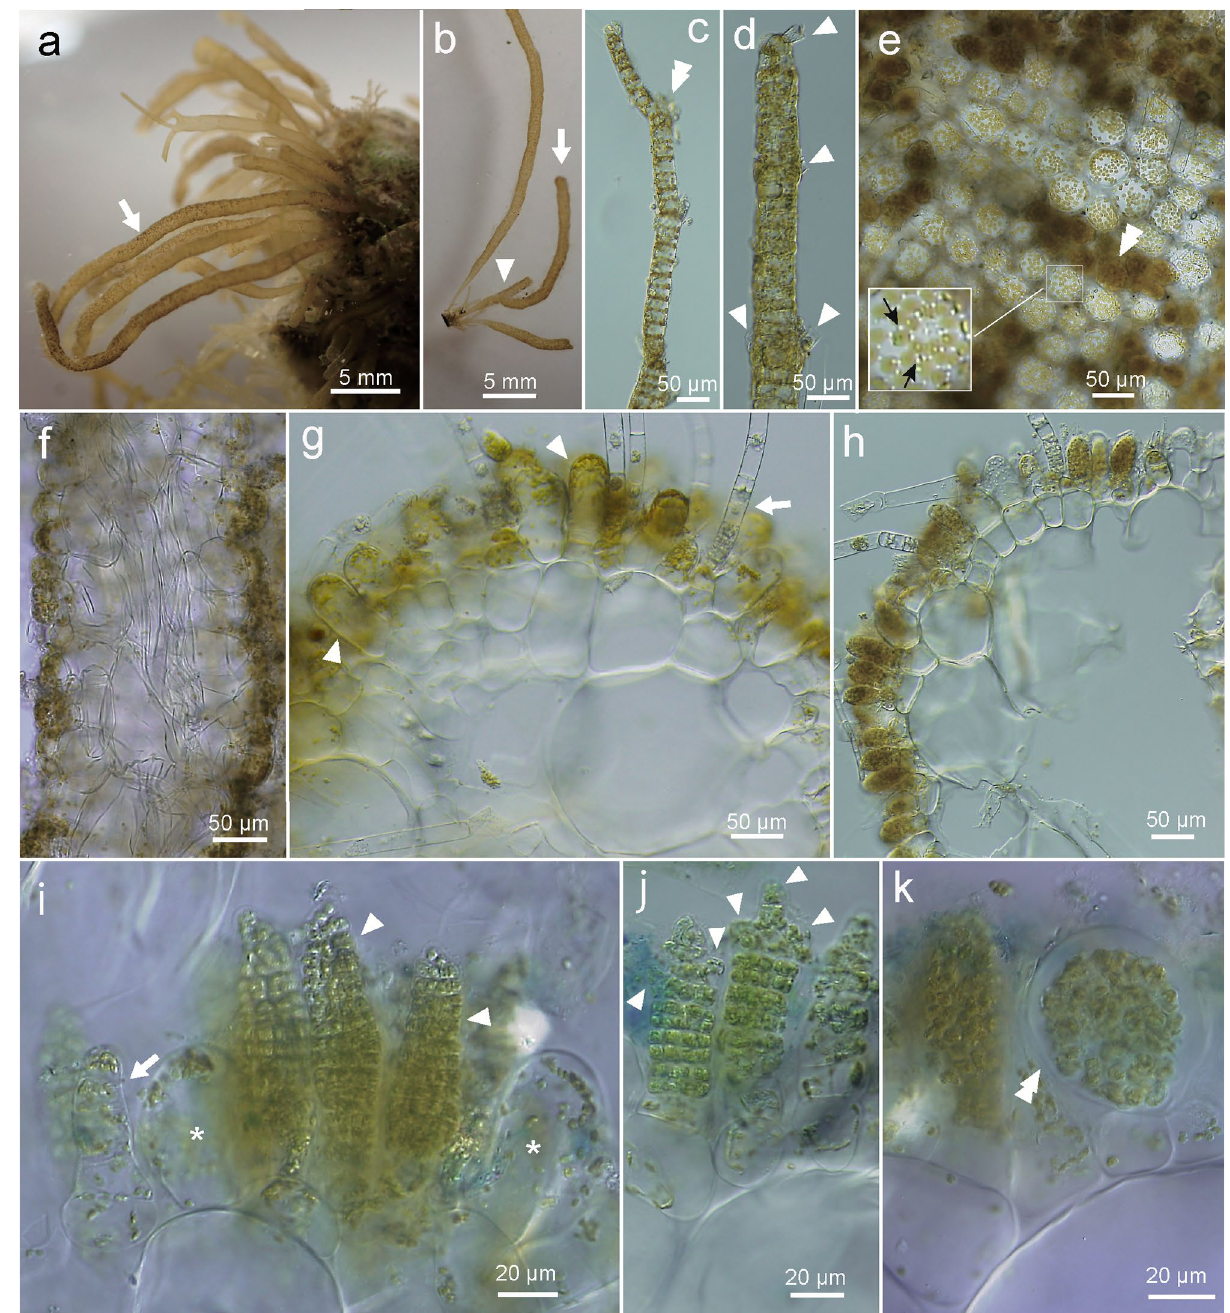
Figure 2. Morphology and anatomy of Setoutiphycus delamareoides gen. & sp. nov. (Suo-Oshima, 12 April 2017 and 21 April 2021) . ( a ) Erect thalli (arrow) growing on shell of dead barnacle. Reproductive structures are recognizable as dark dots. ( b ) Caespitose erect thalli showing a rare branch (arrowhead) and blunt tip (arrow). ( c ) Young uniseriate erect thallus showing sub-sympodial growth, where elongation of the thallus occurs asymmetrically (double arrowhead). ( d ) Juvenile thallus with apical and lateral (arrowhead) phaeophycean hairs. ( e ) Surface view of fertile erect thallus showing cortical cells containing peripheral discoid chloroplasts with projected pyrenoid (arrows; inset at higher magnification) and plurilocular zoidangia (double arrowhead). ( f) Longitudinal section showing large inner cells and pigmented cortical cells. ( g ) Cross section of solid thallus showing cylindrical cortical cells (arrowheads) and a phaeophycean hair (arrow). ( h ) Cross section of mature hollow thallus. ( i ) Plurilocular zoidangia (arrowheads) formed among cortical cells (asterisks). Arrow shows immature plurilocular zoidangium. ( j ) Plurilocular zoidangium forming protruding locules at the distal end (arrowheads). ( k ) Unilocular zoidangium (double arrowhead) borne on subcortical cell. ( a – h ) Fresh specimens. ( i–k ) Preserved in corn syrup and stained with Cotton Blue. [Photographs by H.